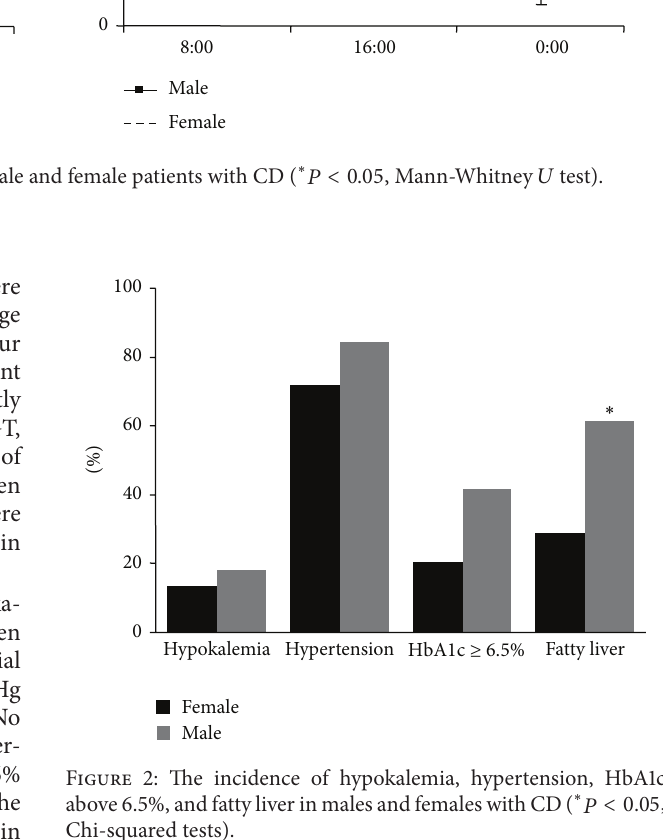
Figure 2: The incidence of hypokalemia, hypertension, HbA1c above 6.5%, and fatty liver in males and females with CD ( ∗ 𝑃 < 0.05 , Chi-squared